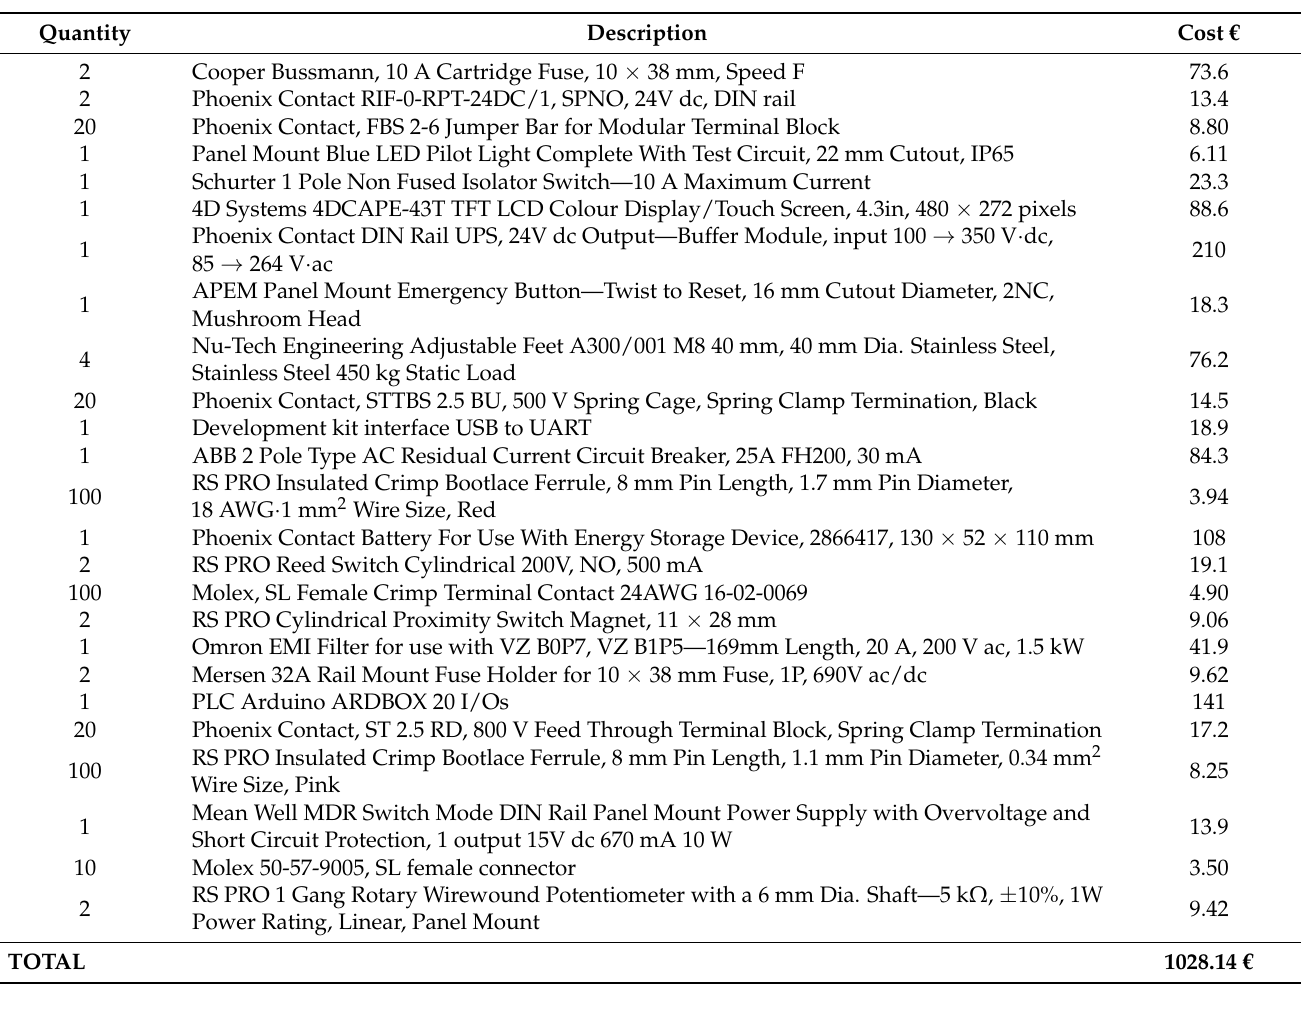
Figure 10. Scheme of the electronic control system. Table 1. Bill of